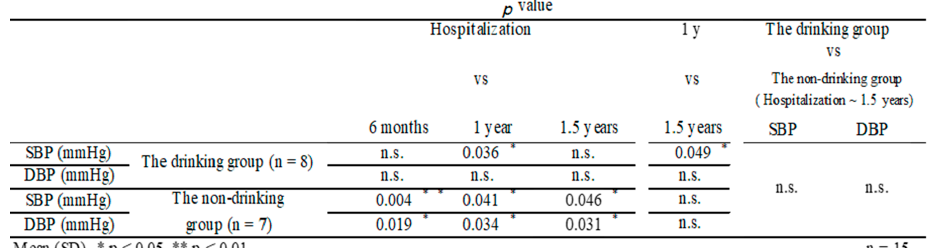
Figure 3. Change in the drinking habit and SS, salt intake and BP. ( a ) In both groups, SS at hospitalization and 1.5 years after leaving had significantly increased ( p < 0.05). SS of the drinking group tended to be lower than that of the non-drinking group. ( b ) The salt intake in the non-drinking group, 1 year, and 1.5 years after leaving were lower than hospitalization ( p < 0.05). From hospitalization to 1.5 years after leaving, salt intake was lower in the non-drinking group than that in the drinking group ( p < 0.01). ( c ) In the non-drinking group, SBPs at hospitalization and 1.5 years after leaving, which showed a decrease ( p < 0.05).